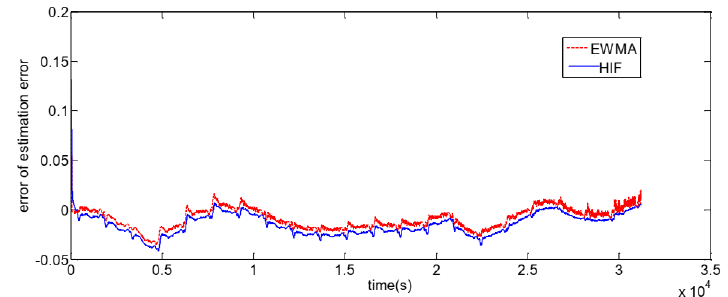
Figure 7. The estimation error curve of the two